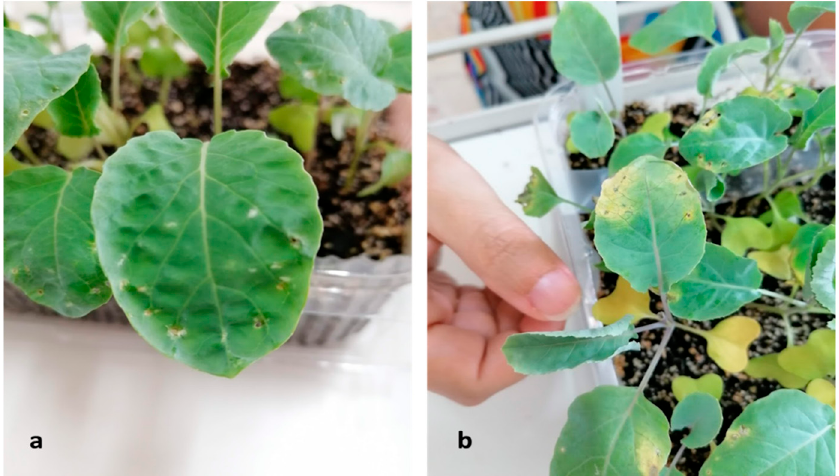
Figure 10 . Infection of Xcc CREA OF 1231.20 in B. oleracea var. botrytis ; ( a ) non-inoculate control; ( b ) symptomatic leaves.